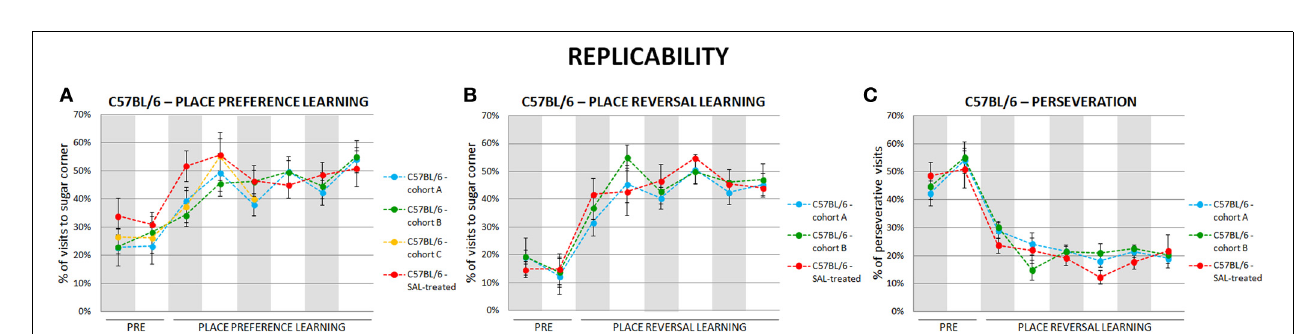
FIGURE 3 | Self-designed automated behavioral tests are highly replicable. The results of place preference learning (A) in four cohorts ( n = 41), reversal learning (B) and perseveration (C) in three cohorts ( n = 30) of C57BL/6 mice. Dots represent the actual data, while dashed lines serve to guide the